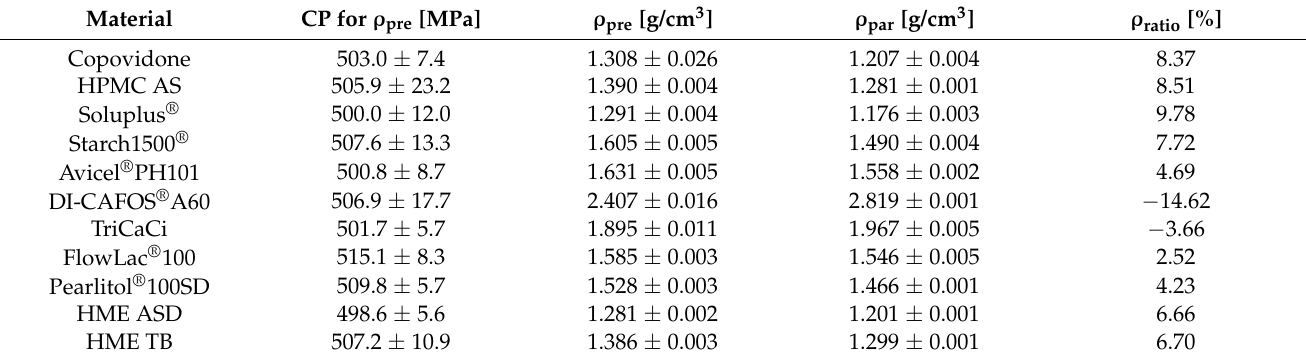
Table 1. Results of density measurements ( ρ pre and ρ par ) and the resulting density ratio ( ρ ratio